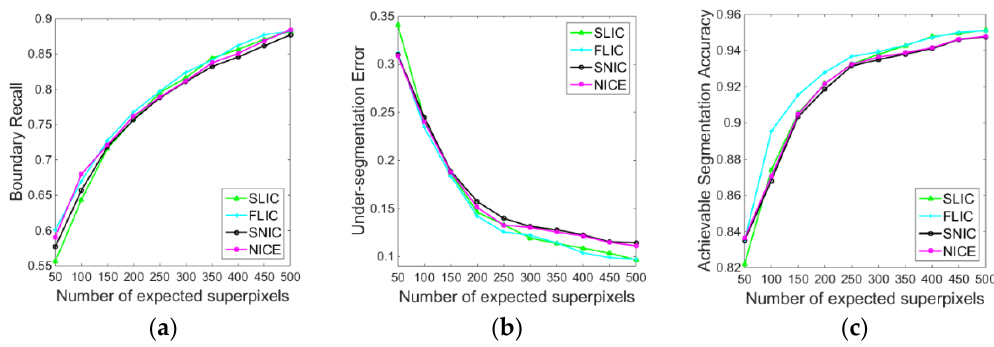
Figure 10. Performance comparison of four algorithms in terms of three quantitative metrics on NYUv2.